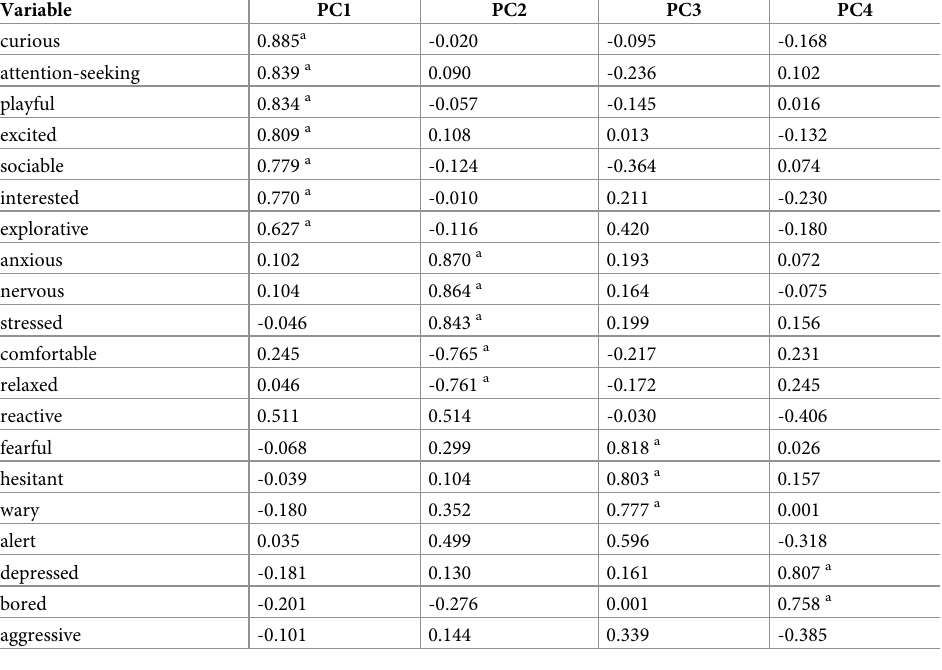
Table 6. Loadings for each QBA term on the four principal components (PC1, PC2, PC3 and PC4) extracted by the PCA